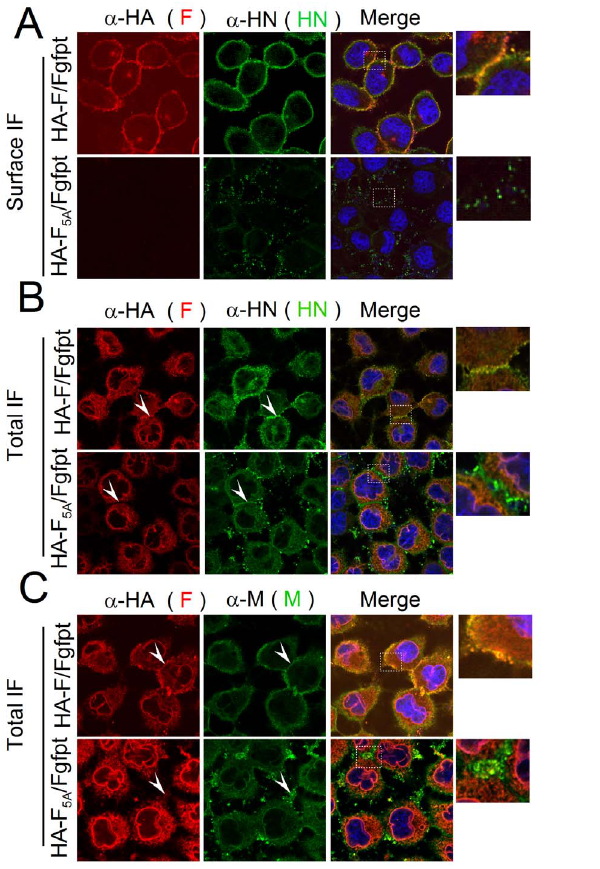
Figure 8. Subcellular localization of the HN and M proteins in the context of wt-HA-F or HA-F 5A . As in figure 6A, but with the use of primary antibodies a -HN in ( A ) and ( B ) or a -M in ( C ) added with a -HA in all the